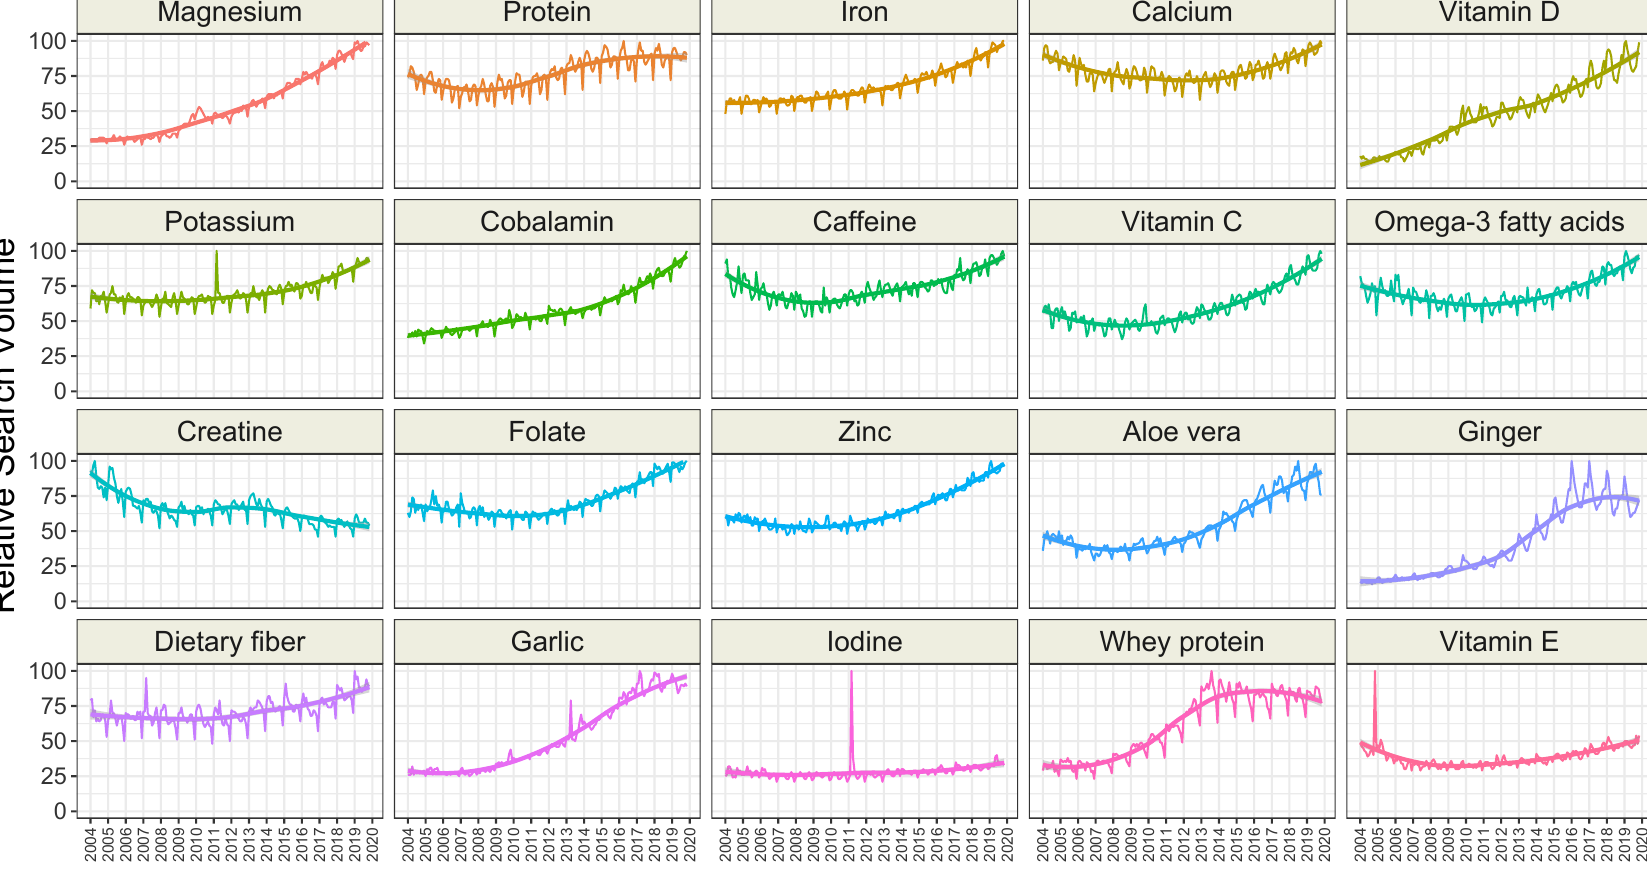
Figure 4. Time trends for relative search volumes of the twenty most popular dietary supplement-related